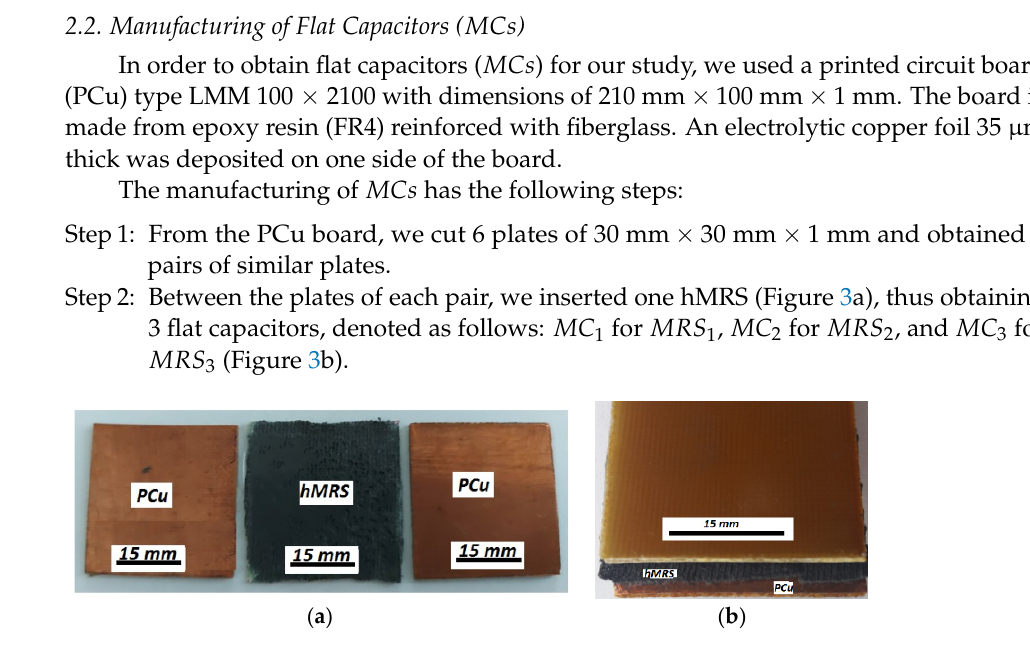
Table 2. V Fe , V SO ,and V GB volumes and Φ Fe , Φ SO ,and Φ GB volumetric fractions of hMRS samples. Table 2. 𝑉 (cid:3007)(cid:3032) ,𝑉 (cid:3020)(cid:3016) , and 𝑉 (cid:3008)(cid:3003) volumes and Φ (cid:3007)(cid:3032) , Φ (cid:3020)(cid:3016) , and Φ (cid:3008)(cid:3003) volumetric fractions of ℎ𝑀𝑅𝑆 samples. 𝒉𝑴𝑹𝑺 𝒔